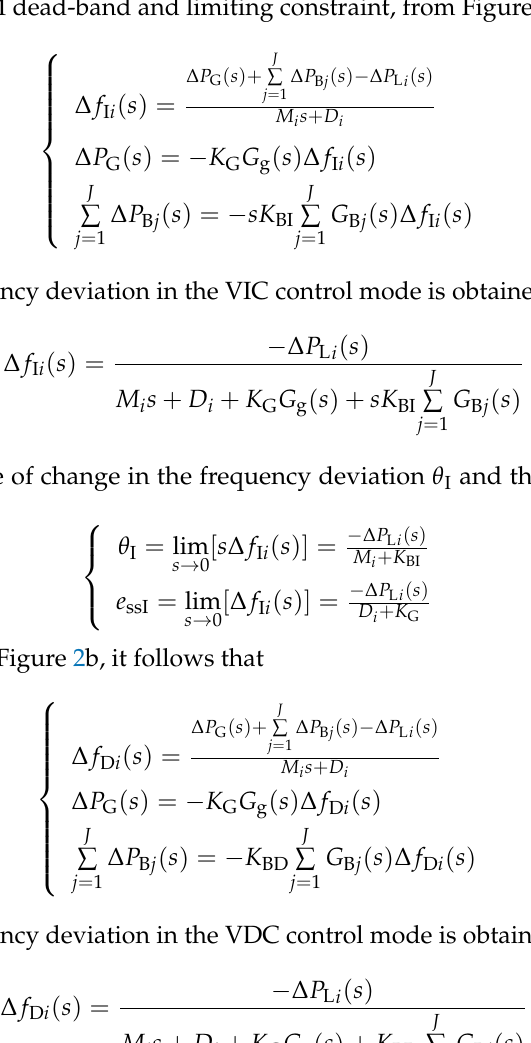
Figure 2. ( a ) VIC control mode structure diagram; ( b ) VDC control mode structure diagram.